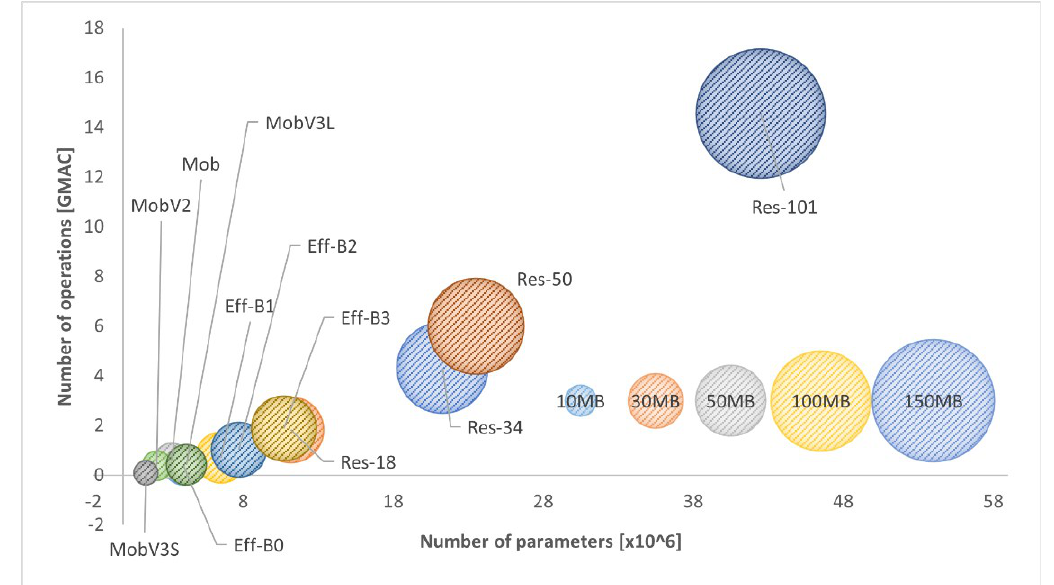
Figure 6. Comparison of all models by number of operations, number of parameters, and model size on disk.